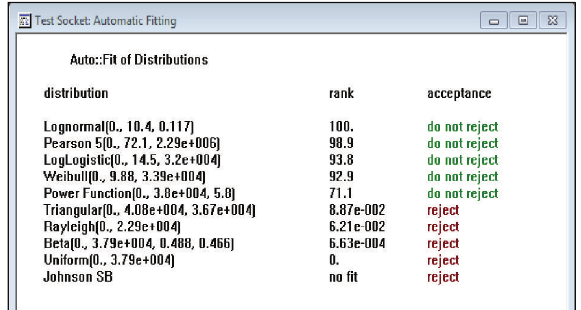
Figure 2: Various distributions fitted to the input data.